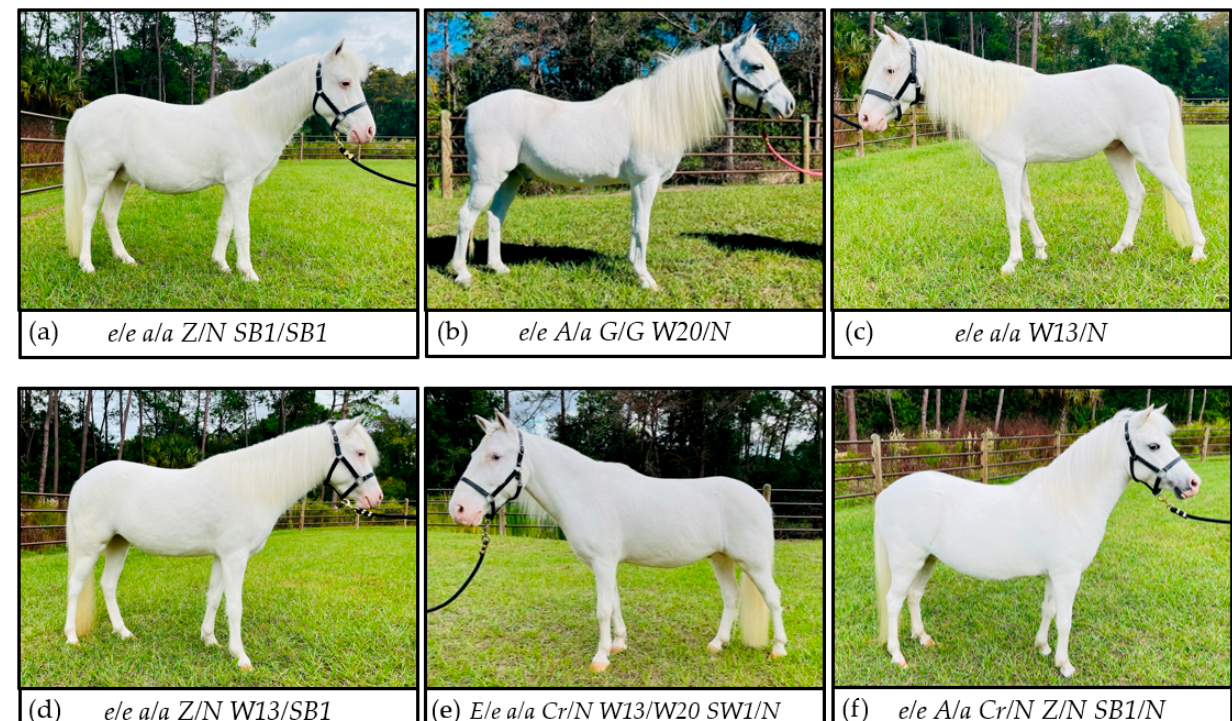
Figure 1. Unregistered Shetland ponies with an all-white coat phenotype and genetic causes. Genotypes and phenotypes are as follows: ( a ) Chestnut base coat ( e/e a/a Z/N ) with all-white coat phenotype and pink skin explained by homozygosity for SB1/SB1 ; ( b ) chestnut base coat ( e/e A/a ) with white coat and dark skin phenotype explained by gray ( G/G ) and W20/N ; ( c ) chestnut base coat ( e/e a/a ) with all-white coat phenotype explained by W13/N ; ( d ) chestnut base coat ( e/e a/a Z/N ) and compound heterozygote at the KIT locus W13/SB1 ; ( e ) black base coat ( E/e a/a Cr/N ) with W13/W20 at the KIT locus and with the SW1 allele ( SW1/N ); ( f ) palomino base coat ( e/e A/a Cr/N Z/N ) with SB1/N that does not explain the all-white phenotype.